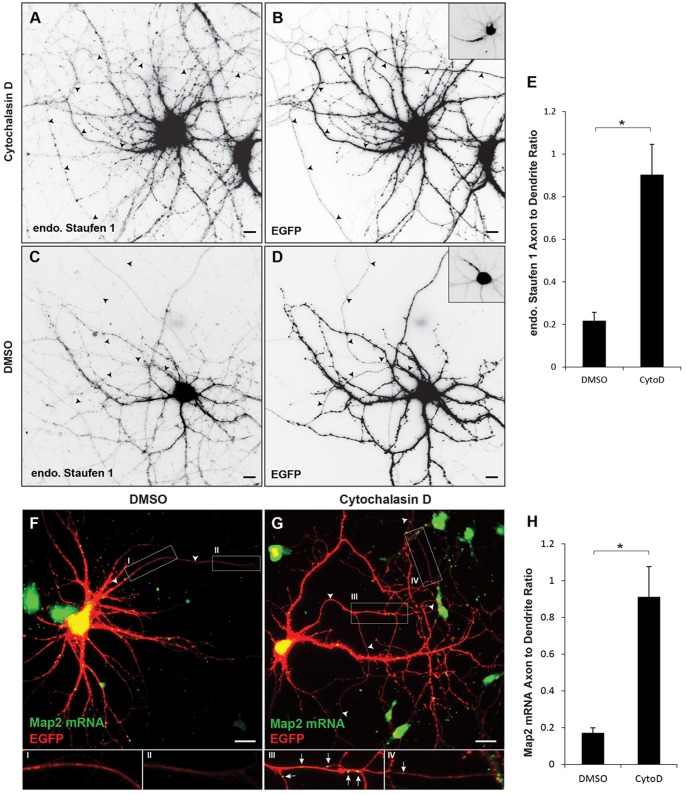
Intact actin filaments are necessary for somatodendritic localization of both endogenous Staufen 1 and Map2 mRNA.
A. Following exposure to Cytochalasin D (4 μM) for 6 hours endogenous Staufen 1 is present in the axon as well as in the dendritic compartment. B. EGFP staining in the same cell as in (A). C. Endogenous Staufen 1 is absent from the axonal compartment of cortical neurons expressing EGFP (D) and exposed to DMSO. Insets show Ankyrin G staining, which labels the axon initial segment of the corresponding cells. E. The axon to dendrite ratio of endogenous Staufen 1 is significantly higher in cells exposed to Cytochalasin D than in cells exposed to DMSO alone. F. In a cortical neuron exposed to DMSO FISH labeling reveals Map2 expression in dendrites, but not in the axon. Insets, I and II, which are high power images corresponding to labeled boxes in (F), show a relative absence of Map2 mRNA staining in the axon. G. In a cortical neuron exposed to 4 μM Cytochalasin D for 6 hours Map 2 mRNA staining is present in both the axon and the somatodendritic compartment. Insets III and IV show the presence of Map2 mRNA staining in axons. H. Map2 mRNA axon to dendrite ratio is significantly higher in cells exposed to Cytochalasin D than in cells exposed to DMSO alone. * indicates p<0.001 (Wilcoxon). Scale bar is 10 μm.